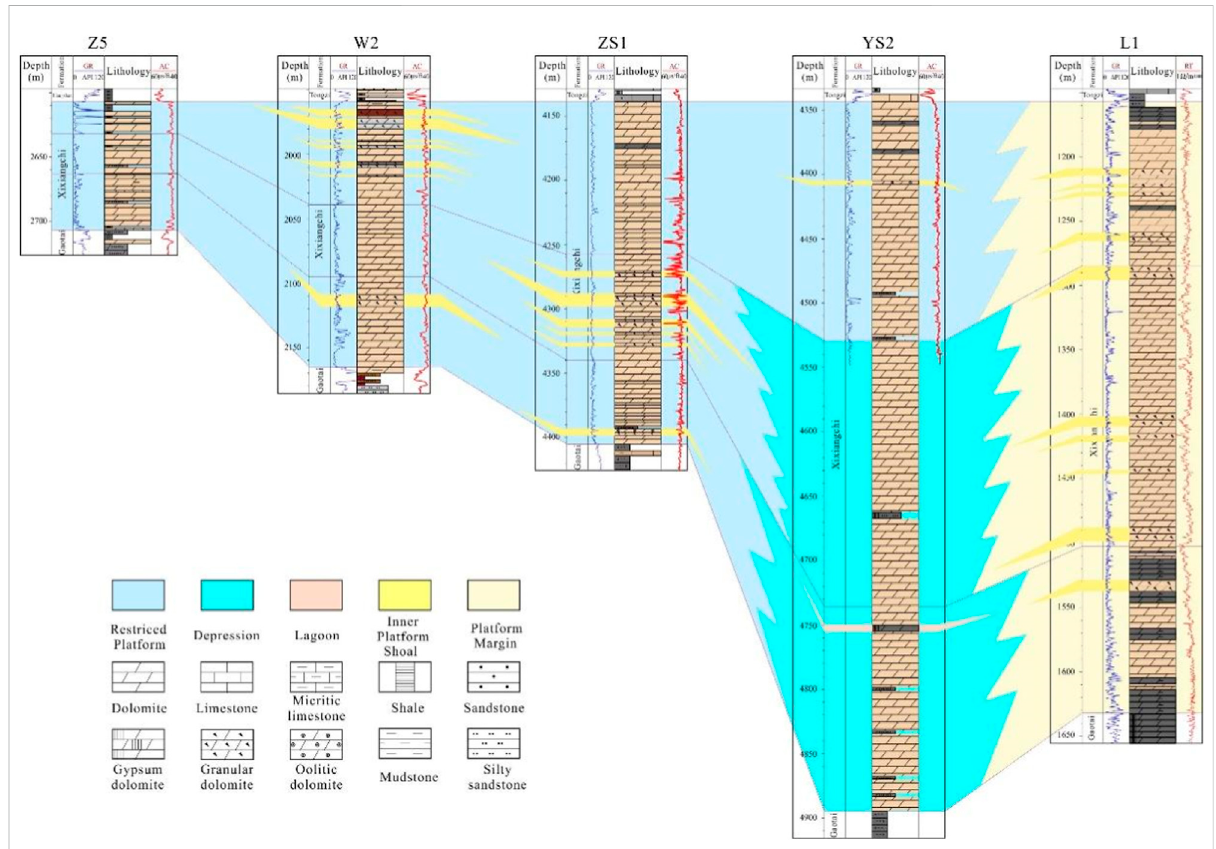
FIGURE 4 The stratigraphic correlation diagram and reservoir distribution of Xixiangchi Formation from well Z5 to well